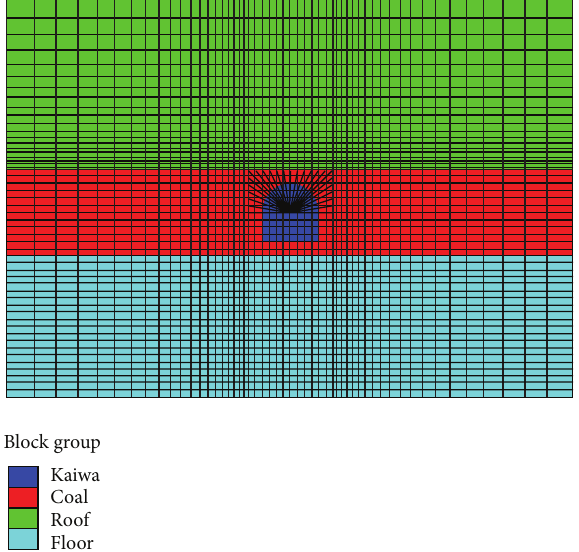
Figure 4: Finite element model of the interbedded structure.